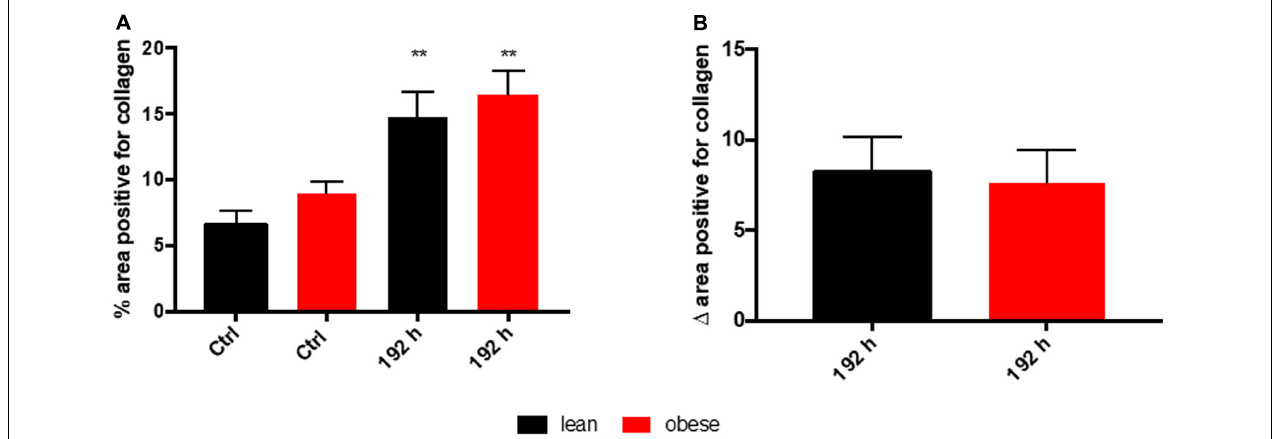
FIGURE 2 | Collagen deposition in the lung as a response to trauma is independent of diet after 192 h. Determination of collagen content in the lung using picrosirius red staining based on auto-fluorescence properties of the dye. The percent of the positive areas for collagen in control mice as well as 192 h post trauma ( n = 5) (A) is depicted next to a graph depicting the differences of the post trauma mice to the respective control mice (B) . The data is presented as mean ± SEM. Statistical significance was determined using two-way ANOVA followed by an uncorrected Fisher’s LSD test ( α = 0.05). ** p <